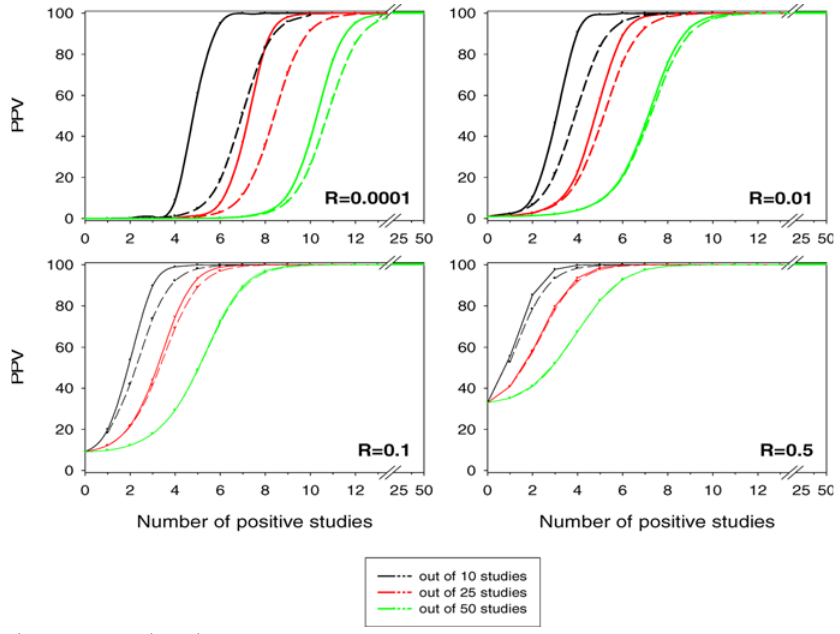
Figure 2. Positive Predictive Value for Research Findings Being True for At Least r Positive Studies Out of Ten, 25, and 50 Studies for Pre-Study Odds R of 0.0001, 0.01, 0.1, and 0.5 (α = 0.05) Dashed lines refer to power of 0.2 and solid lines to power of